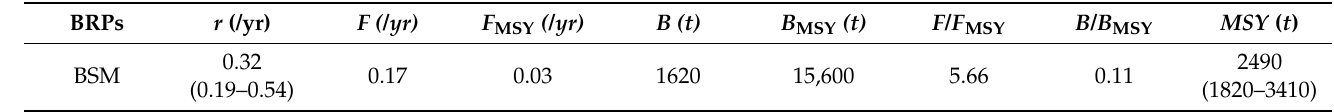
Table 6. Estimated results with 95% confidence interval for management based on BSM analysis from catch and effort data using BSM